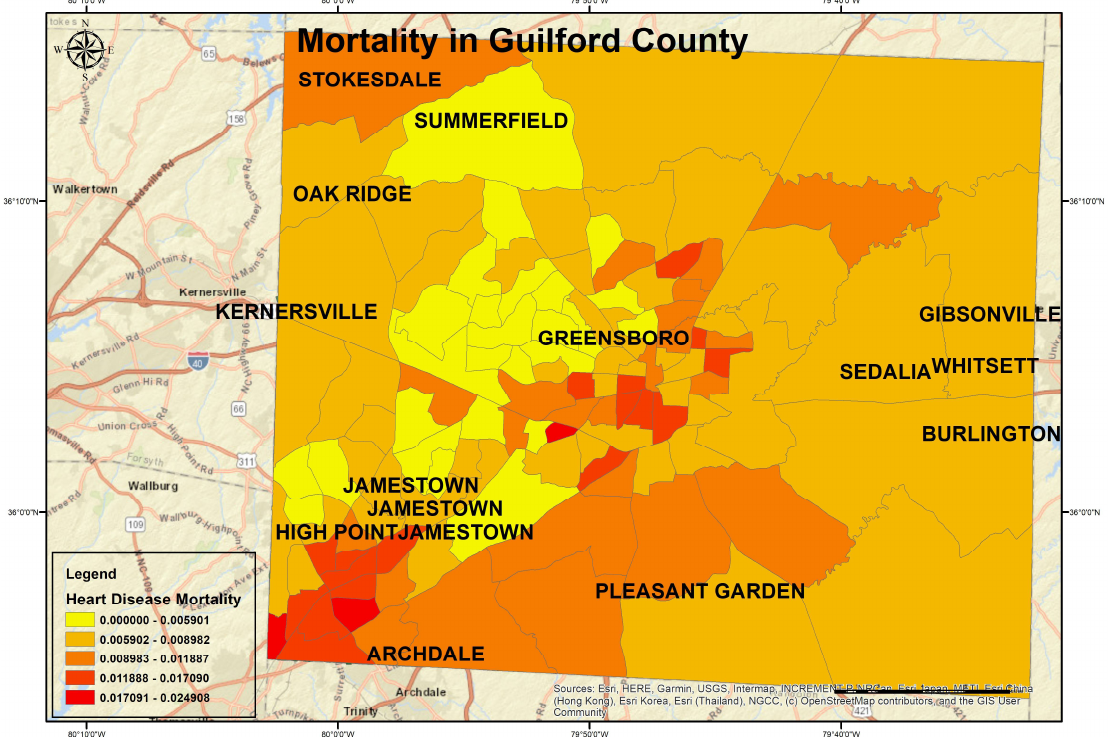
Figure 4. Heart disease mortality rates in Guilford